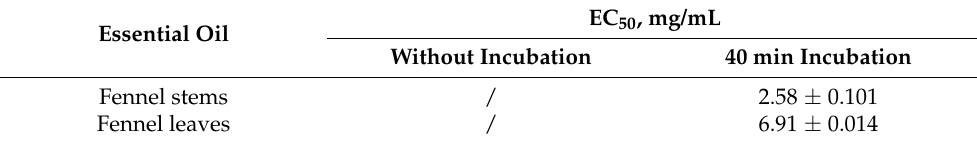
Table 4. EC 50 values of essential oil from the wild fennel stems and leaves.